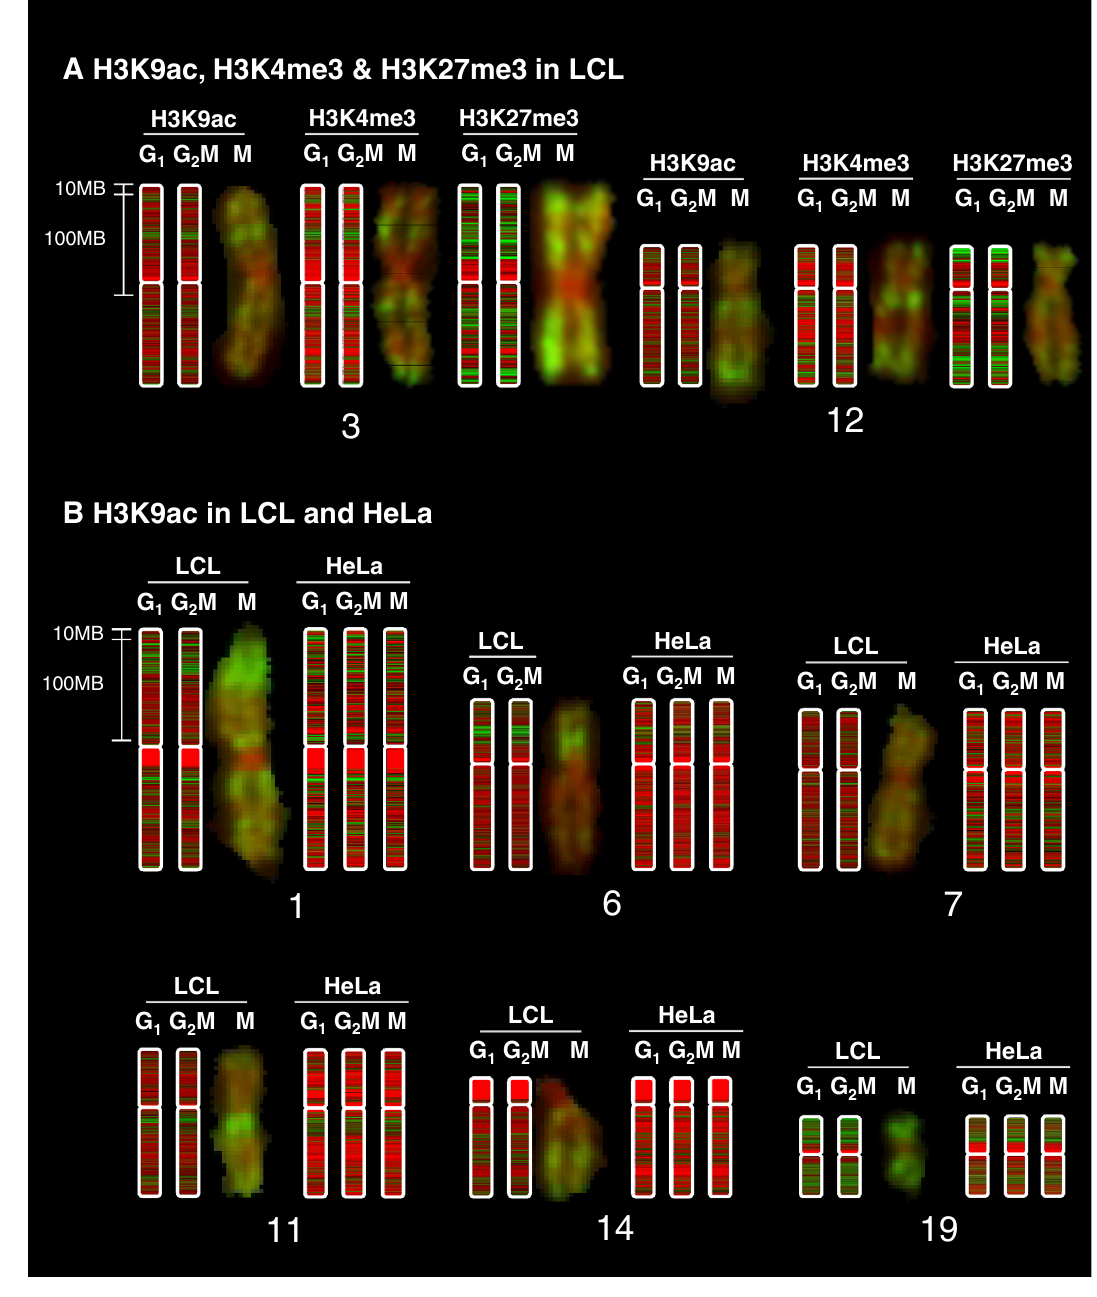
Figure 1. Metaphase chromosome banding patterns are conserved through the cell cycle but differ between cell types. ChIP-seq data were analysed using rolling windows and displayed as blocks using a red-green colour scale in SeqMonk. A scale bar is shown, and as a rough guide, the blocks of centric heterochromatin (uniform red) at chr1q1 are 20 Mb in size. Maximum resolution (1 pixel) is approximately 1.5 MB. G 1 and G 2 M fractions were sorted by FACS (LCL) or centrifugal elutriation (HeLa). Mitotic HeLa cells were harvested by mitotic shake- off. LCL ChIP-seq karyotypes in G 1 and G 2 M are shown aligned with metaphase chromosomes stained with antibodies to H3K9ac, H3K4me3 and H3K27me3 as described previously 32 ( A ). H3K9ac karyotypes in G 1 , G 2 M and M are shown in LCL and HeLa cells ( B